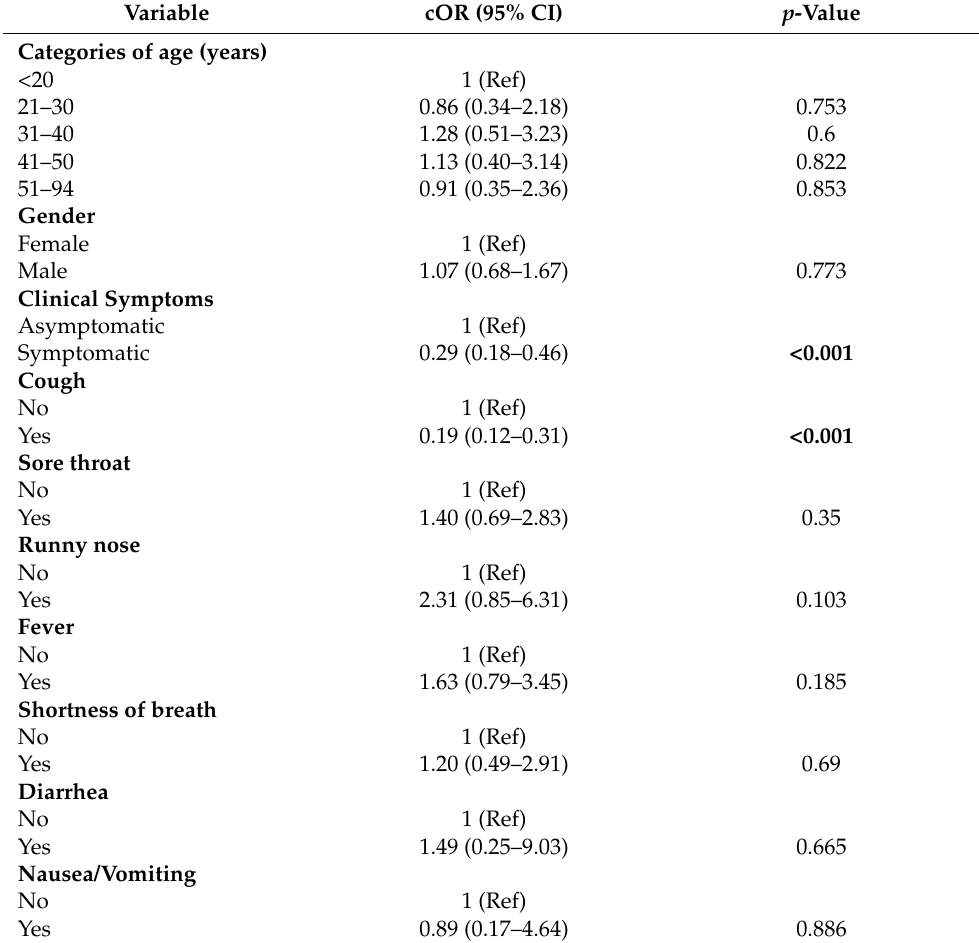
Table 2. Clinical and socio-demographic risks factors associated with SARS-CoV-2